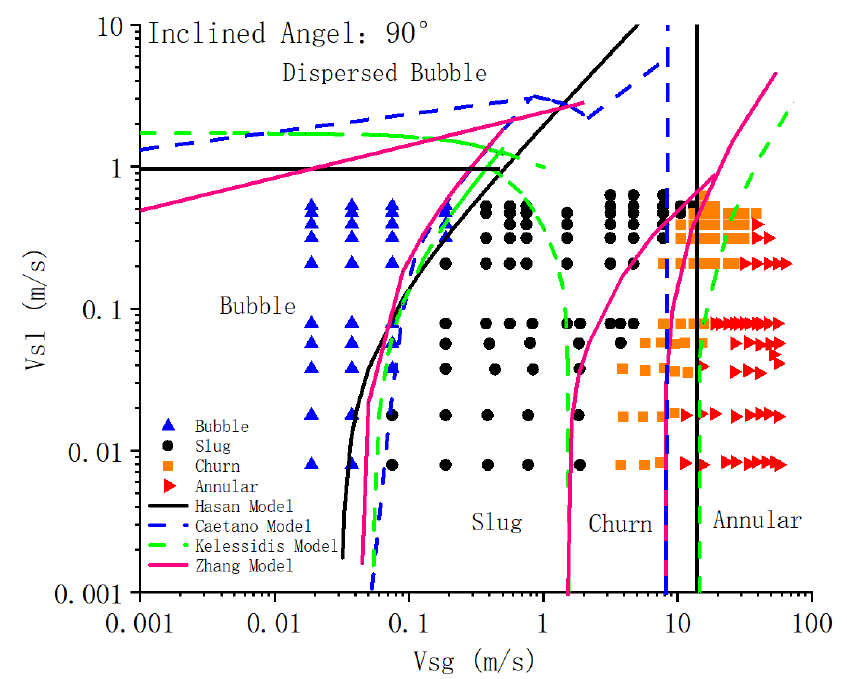
Figure 6. Comparison between flow pattern diagrams of different models and experiments with 90 ◦ inclination angle.